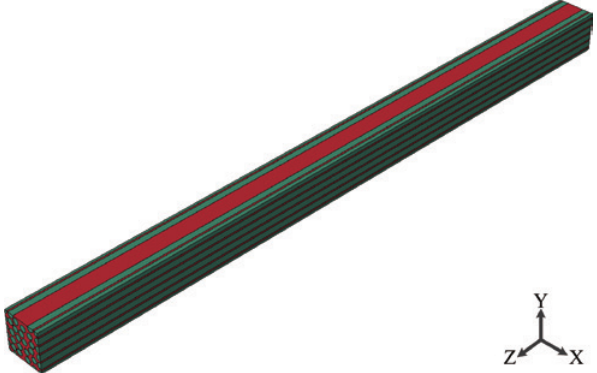
Figure 4: The micromechanical model.